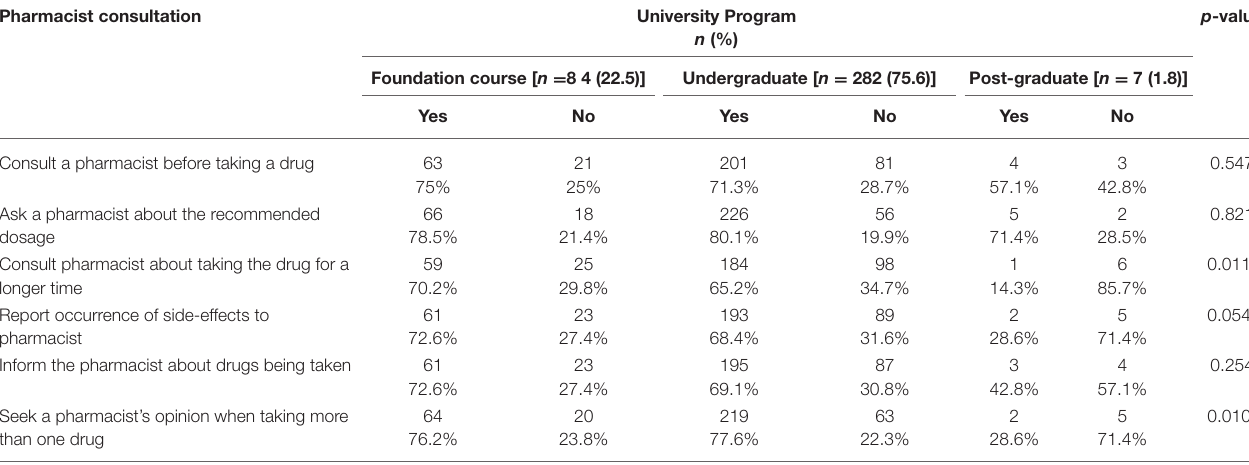
TABLE 5 | Pharmacists’ role in self-medication among students ( N =